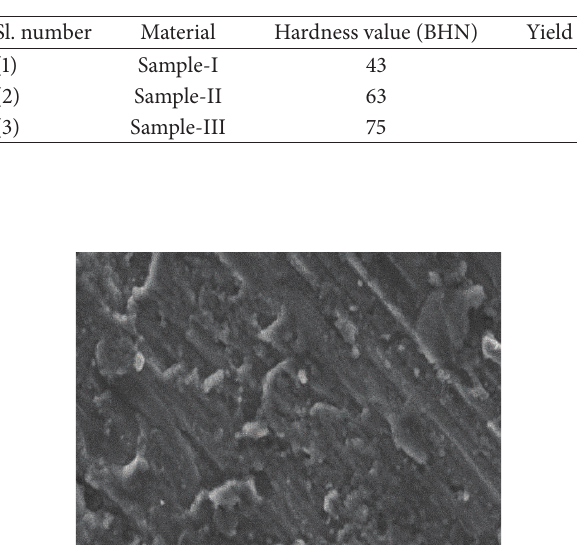
Table 1: Mechanical properties of the prepared composites.